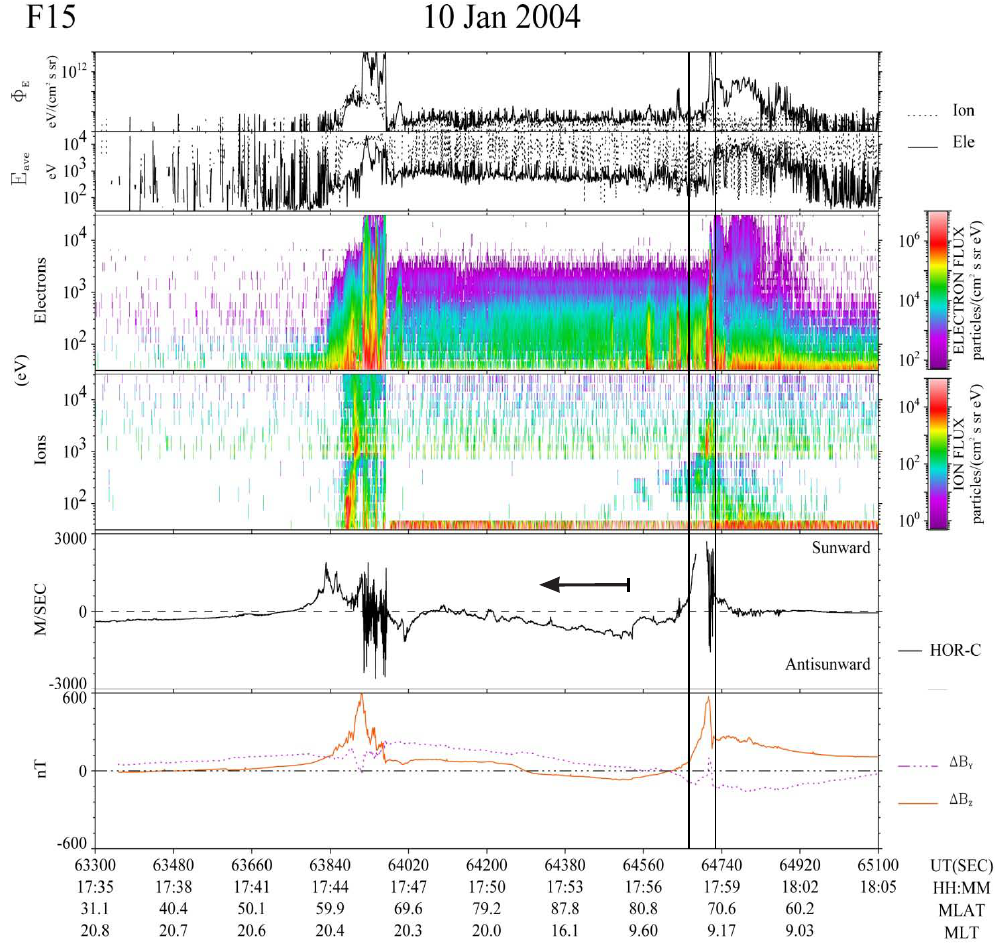
Fig. 8. DMSP F15 data obtained during the pass from pre-midnight to pre-noon MLTs in the interval 17:35–18:05UT, as indicated in Fig. 3. Panels from top to bottom shows precipitation energy fluxes (ions/electrons), average energies, electron and ion spectrograms, cross-track ion drift, and magnetic deflection components across ( B z ; east-west) and along ( B y ) the track. Entry into and subsequent exit of the polar cap occurred at 20:00MLT/66 ◦ MLAT and 09:00MLT/71 ◦ MLAT, respectively. Channel of enhanced sunward convection at 09MLT/71 ◦ MLAT is marked by vertical guidelines. End of the interval of substorm electrojet activity is marked by an arrow in the convection